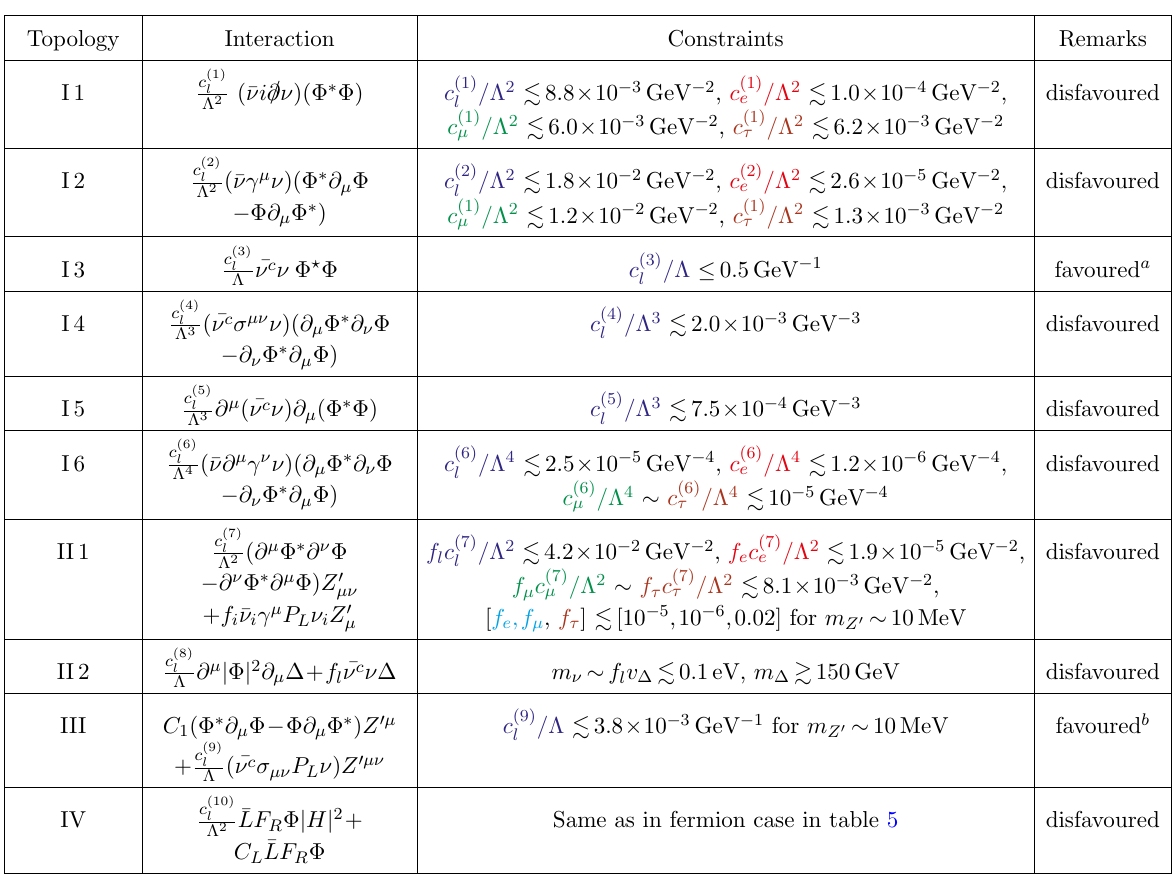
Table 4. Summary of neutrino-DM e(cid:11)ective interactions. c l and c e;(cid:22);(cid:28) represent the coe(cid:14)cients of interactions for the gauge non-invariant and gauge-invariant forms respectively. The colour coding for the constraints is: Z ! inv , LEP monophoton+ =E , Z ! (cid:22) + (cid:22) (cid:0) , Z ! (cid:28) + (cid:28) (cid:0) and ( g (cid:0) 2) e;(cid:22) . We T also remark whether the interactions are favoured in context of the 1% (cid:13)ux suppression criteria as mentioned earlier.